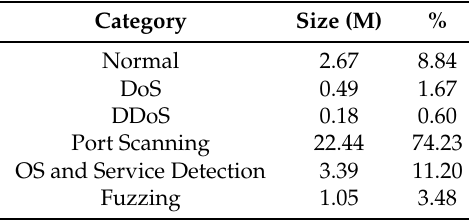
Table 4. Distribution of records in the second SDN